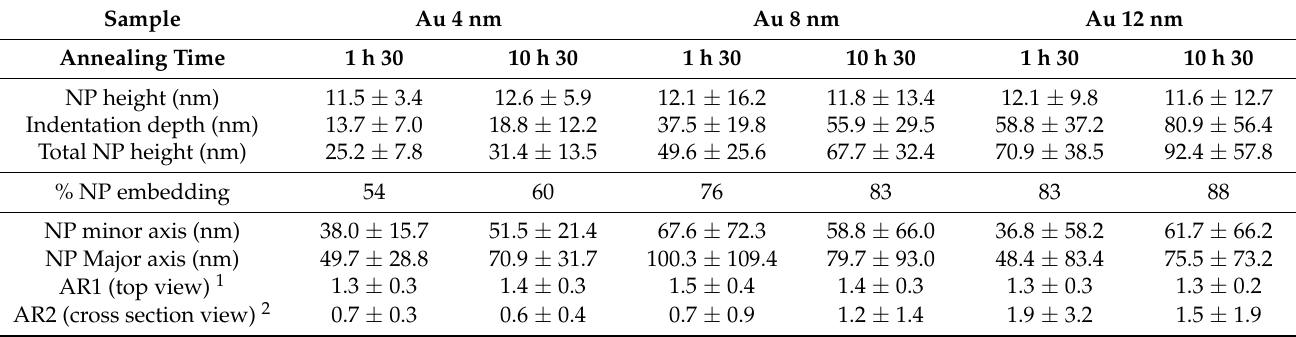
Figure 1. ( a ) XRD patterns of the Au NPs deposited over glass substrates, as a function of the Au nominal thickness and annealing time; ( b ) Au crystallite size estimation using Scherrer equation. Table 1. Average data parameters obtained from AFM images concerning the morphologies of both Au NPs and their indentations in the glass surfaces (mean value ± standard